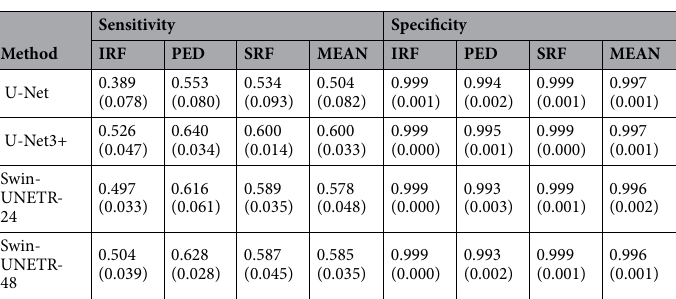
Table 4. Method comparison results. Mean and (std) of the sensitivity and specificity calculated on the test set over a 5-fold CV per class and as a weighted